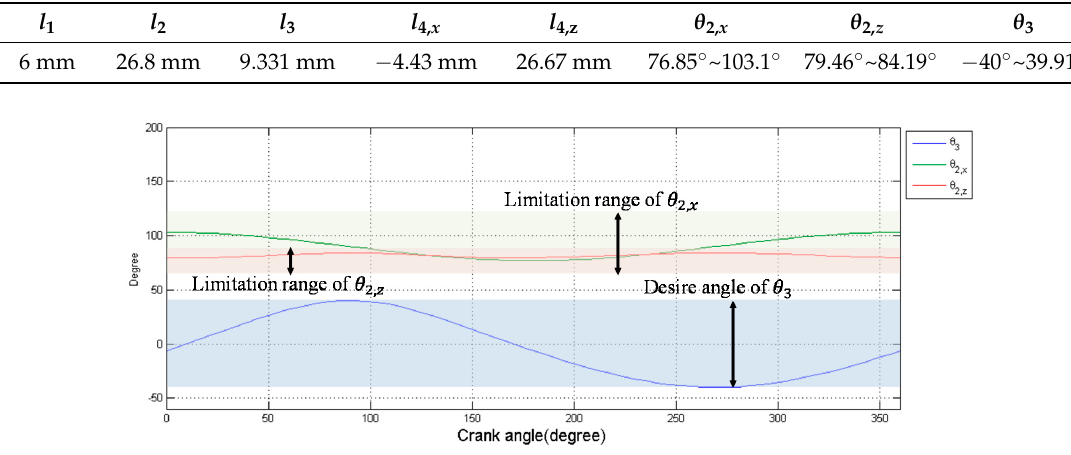
Figure 11. Values of θ 2, x , θ 2, z , and θ 3 with respect to the crank